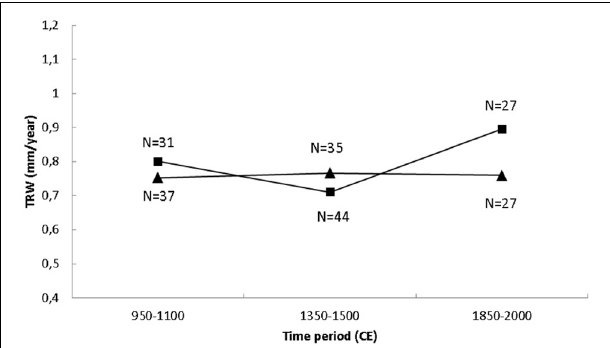
FIGURE 6 | Measured yearly Scots pine growth (in mm) averaged over three 150-year windows: 950–1100 CE, 1350–1500 CE, and 1850–2000 CE for the tree-line (triangle) and lake-shore (square) samples. Here the juvenile phase of the growth was removed before the averaging. N is the number of the samples used in the calculations of the mean tree-ring